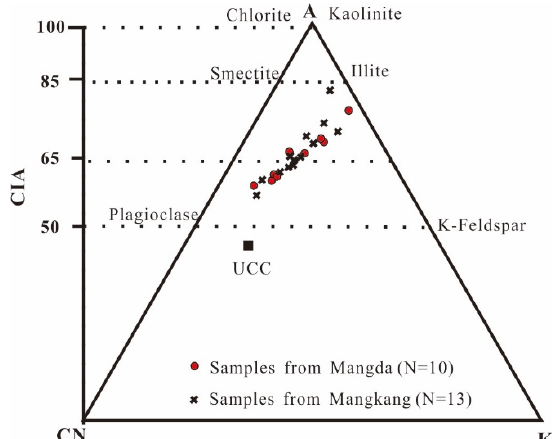
Figure 7. A-CN-K diagram of the sandstones in Qamdo district (after McLennan et al. [60] and Fedo et al.; [59]). Fedo et al.;